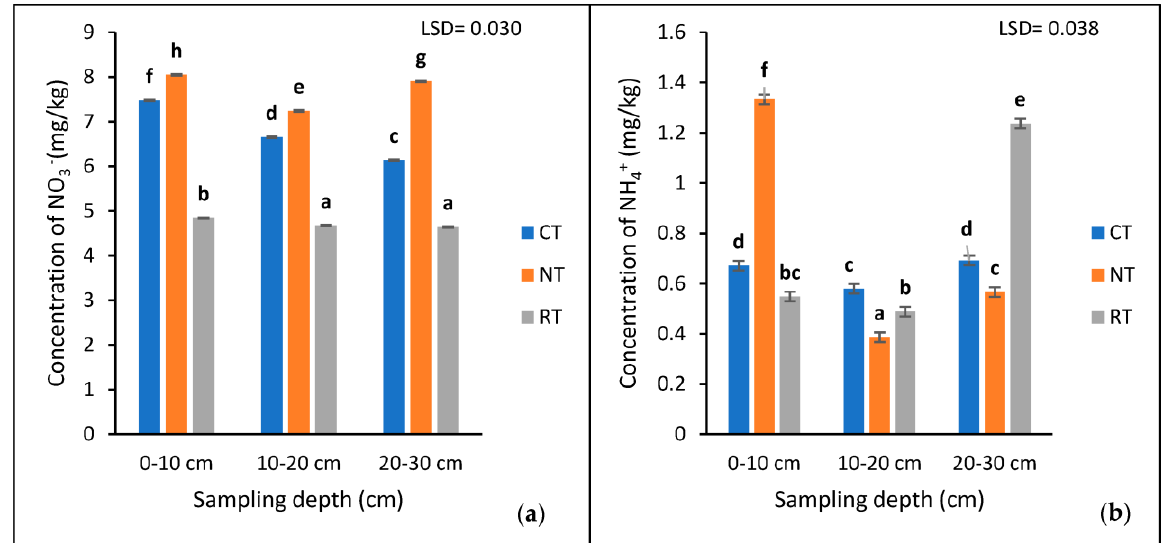
Figure 3. The concentration of extractable NO 3 − ( a ) and NH 4+ ( b ) at three sampling depths (0 − 10, 10 − 20, and 20 − 30 cm) of the three tillage treatments (CT, NT, and RT) recorded after 17 years of trial establishment. cm = centimetre. The bars not sharing the same letter differ significantly at LSD ( p = 0.05).